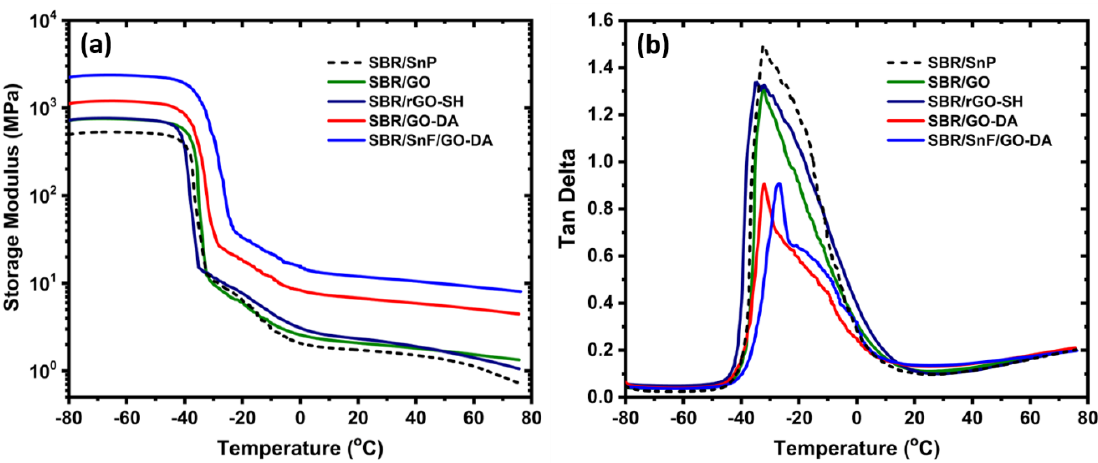
Figure 8. Dynamic mechanical analysis (DMA) plots obtained at 1 Hz for the SBR composites at a broad temperature range ( a ) storage modulus and ( b ) tan δ values.